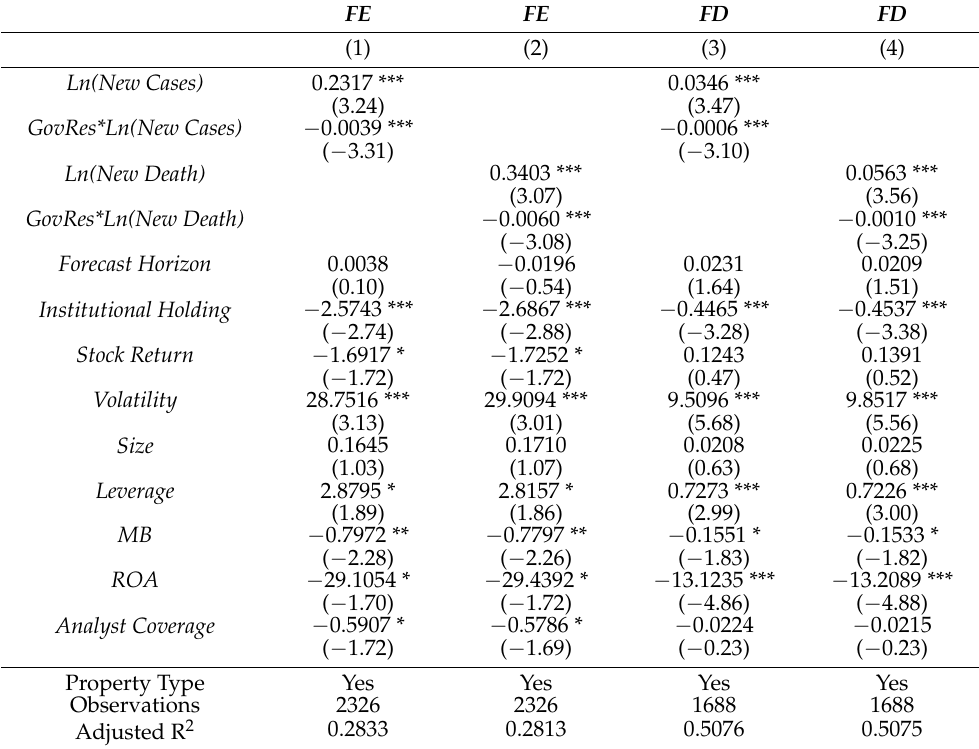
Table 6. Robustness Analysis–Alternative Measures of the Pandemic